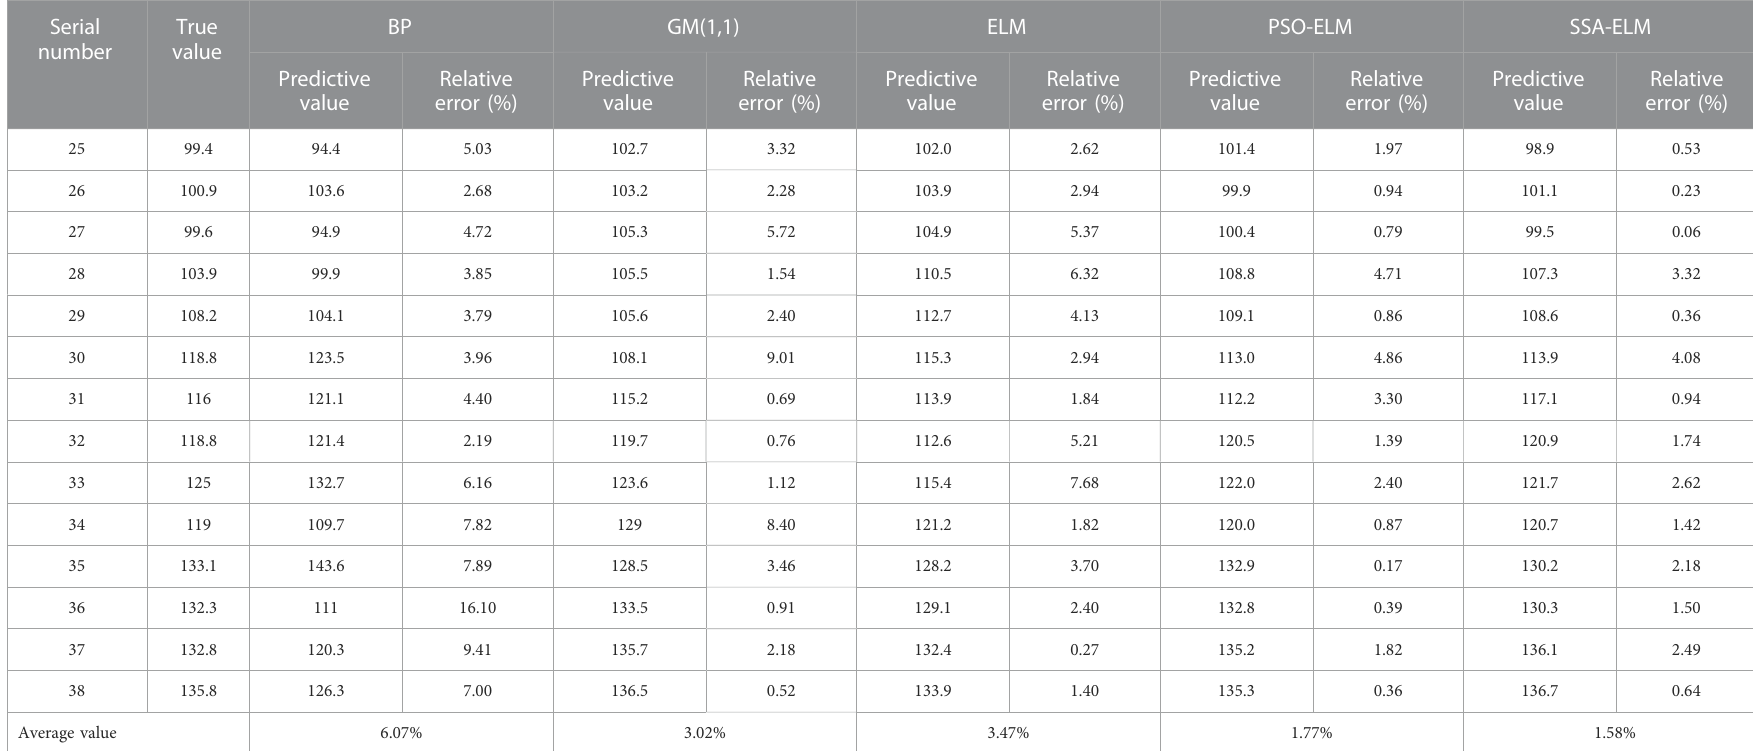
TABLE 2 Prediction errors of fi ve